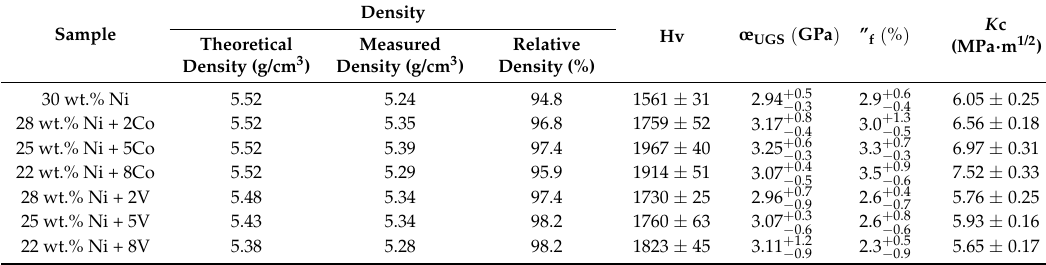
Figure 11. Compression engineering stress-strain curves of the (TiC x N y –TiB 2 )/Ni cermets. ( a ) (TiC x N y –TiB 2 )/Ni cermets with different Ni and Co contents. ( b ) (TiC x N y –TiB 2 )/Ni cermets with different Ni and V contents. Table 1. Room-temperature compression properties, impact toughness, microhardness and density of (TiC x N y –TiB 2 )/Ni cermets with different Co and V contents.